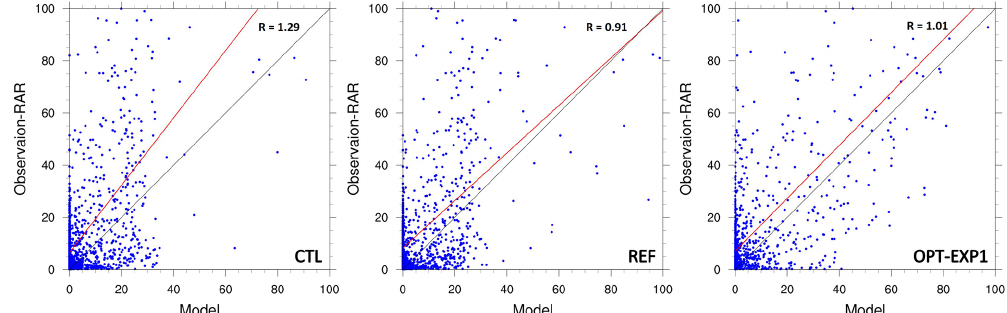
Figure 6. Scatter plot of CTL, REF, and OPT-EXP1.